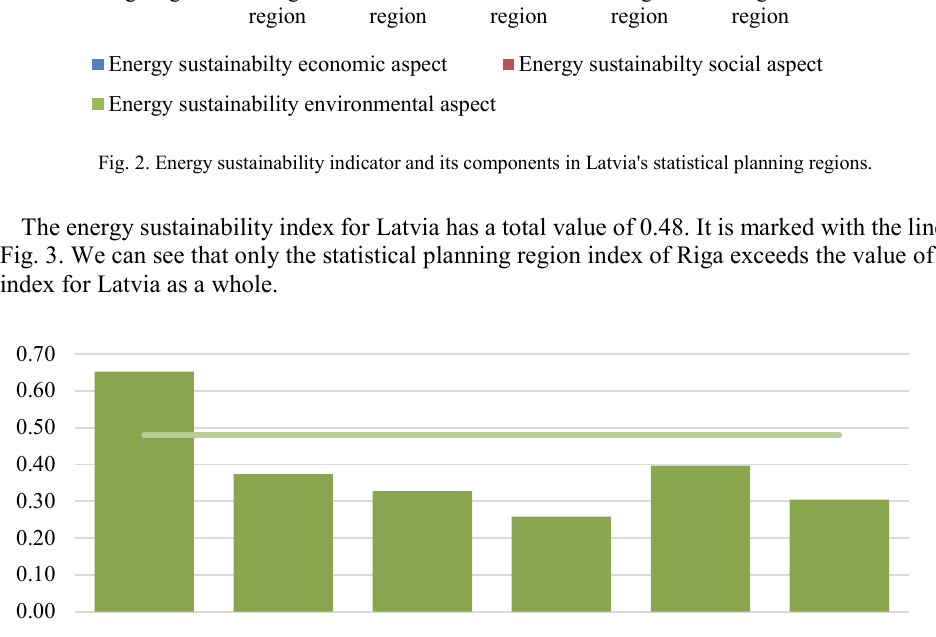
Fig. 3. Energy sustainability index in Latvia and statistical planning